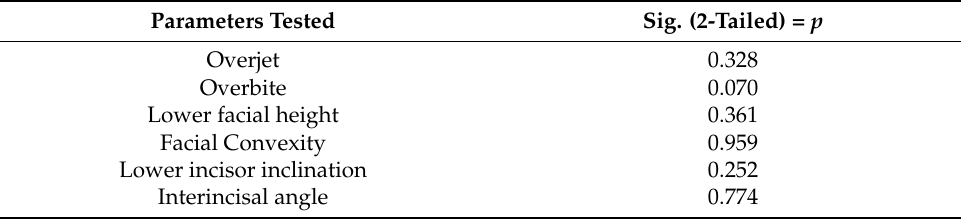
Table 8. p results for the independent t-tests comparing metal and woodwind